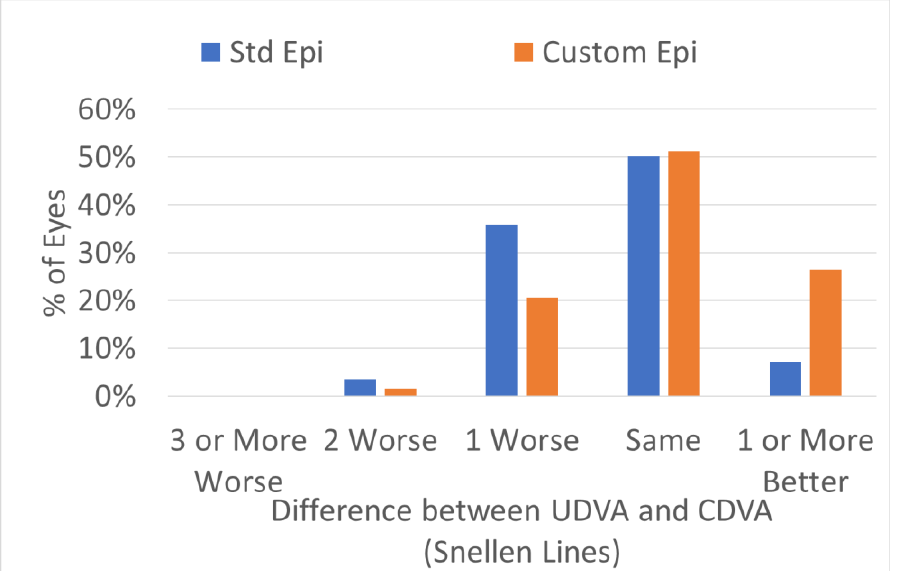
Figure 6. Efficacy expressed in Snellen lines. The post-operative UDVA was the same as the preoperative CDVA, i.e., 0 ± 0.7 lines, for the customized epithelium group; the UDVA was −0 .4 ± 0.7 lines worse than the preoperative CDVA in the standard epithelium profile group ( p = 0.3).